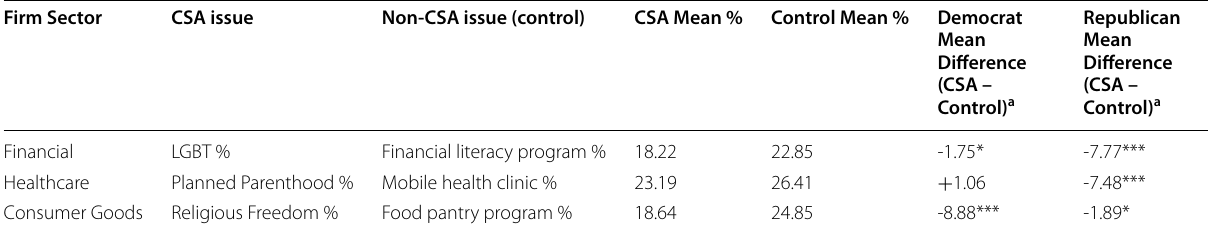
Table 4 Paired t-test of mean % difference between CSA portfolio allocation vs. non-CSA control portfolio allocation by Republican